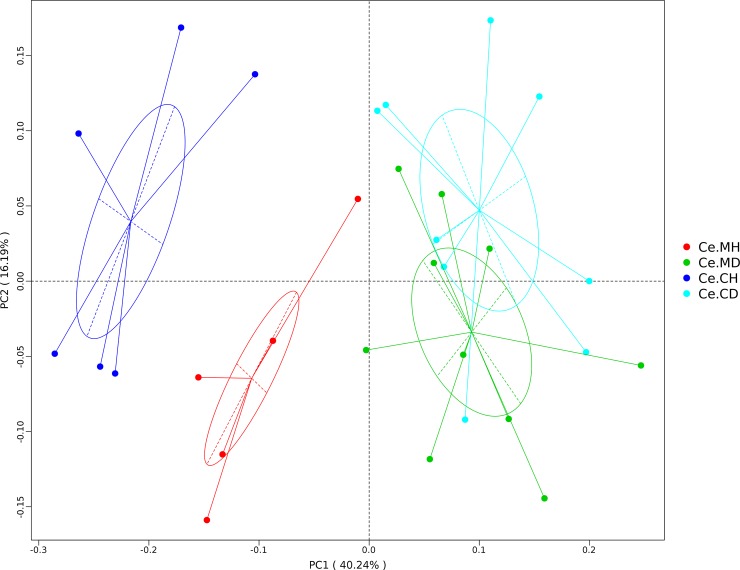
Principal coordinate analysis (PCoA) of the weighted UniFrac distances for each group.The percent variation explained by each principal coordinate is indicated on the X and Y axes.